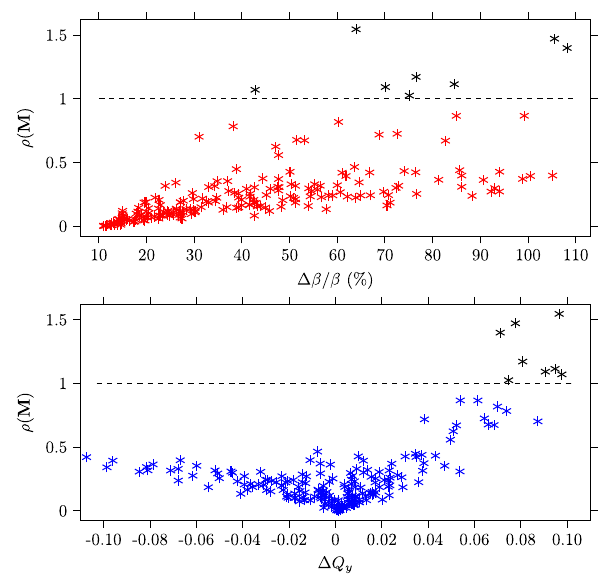
FIG. 10. ρ ð M ð Δ β for beta beating produced by randomly β ÞÞ distributed field errors for an initial vertical tune Q Top: Versus beta beating. Bottom: Versus tune